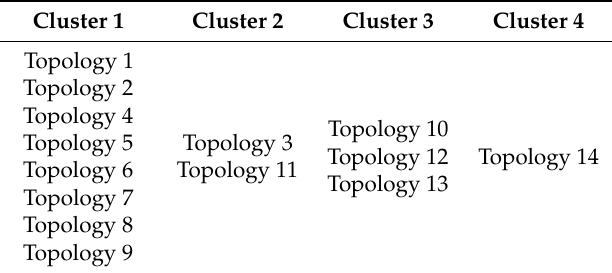
Figure 4. Variation of short circuit level deviation of topologies. Table 11. Topologies divided into clusters.